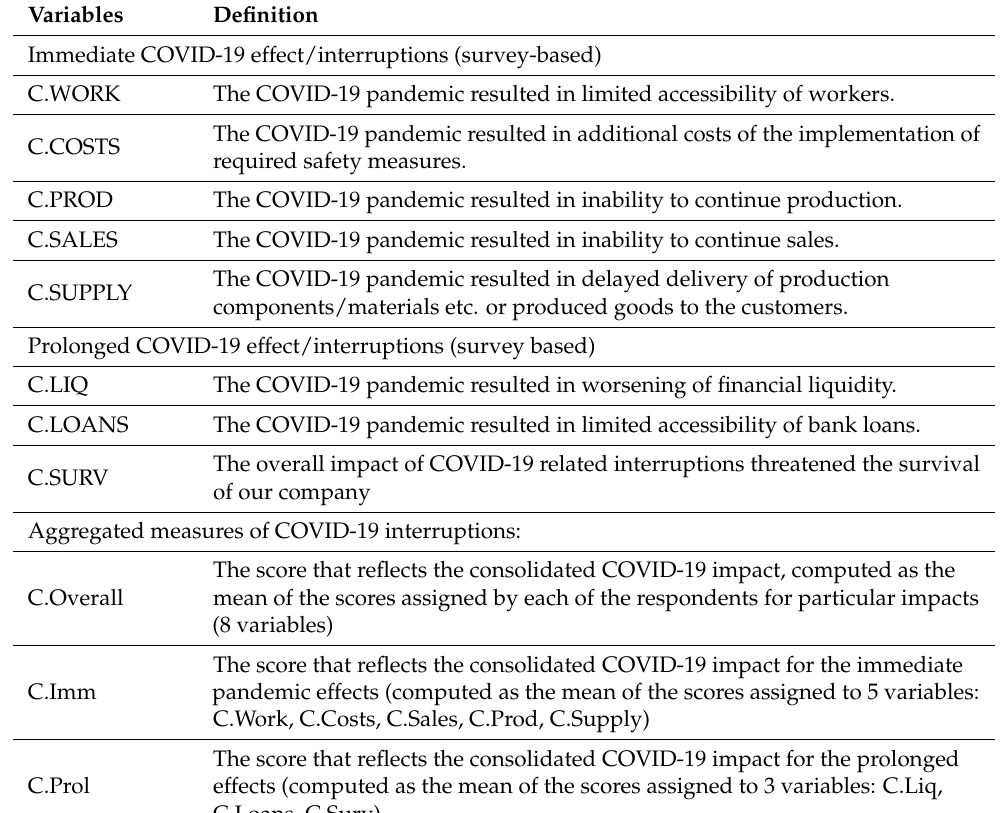
Table 1. The variables and the related survey questions in COVID-19 perceptions